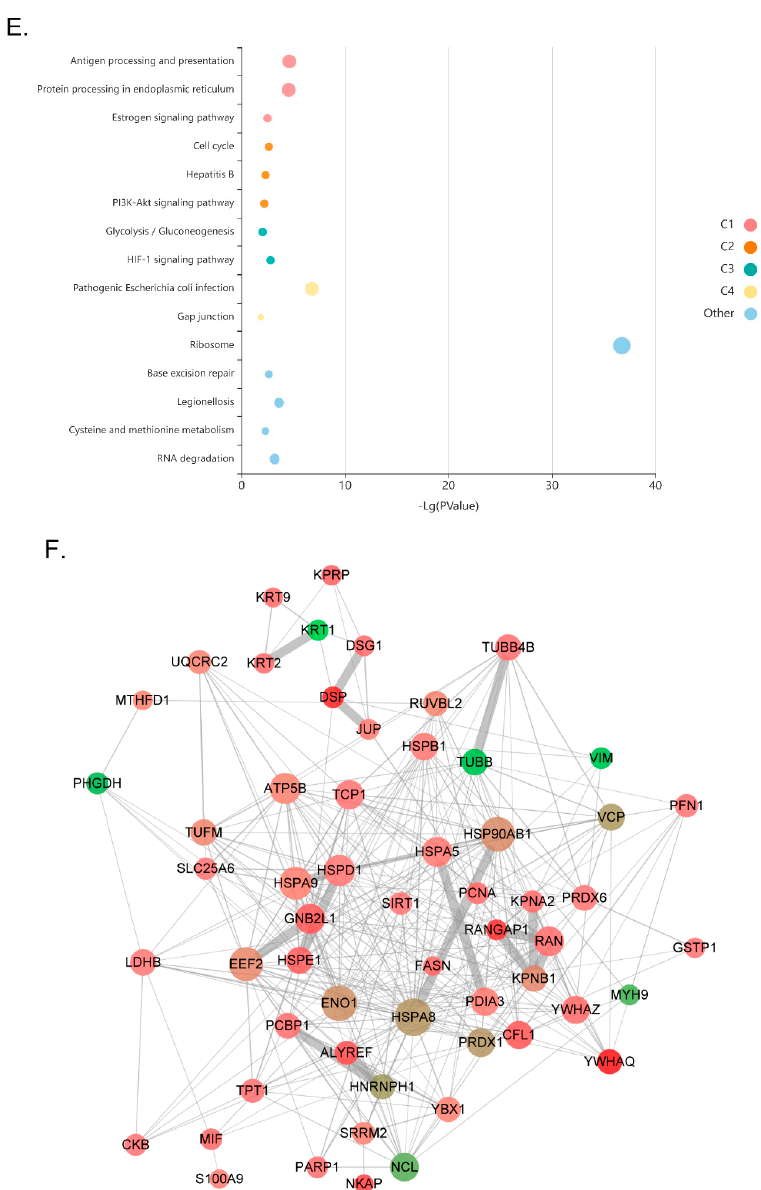
Figure 2. Proteomics analysis of activated SIRT1 interactome. ( A ) Workflow of SIRT1 interactions involving samples preparation and mass spectrometry analysis. ( B ) PCA analysis. SVD with im- putation was used to calculate principal components. X and Y axis showed principal component 1 and principal component 2 that explain 24.3% and 19.5% of the total variance, respectively. N = 9 data points. NC: negative control. CTR: control. Res: resveratrol. ( C ) Heatmap. ( D ) Enrichment of the expressed genes at the secondary GO Term in a significantly up-regulated or significantly down-regulated expression. The abscissa was the number of genes. The ordinate was the GO Term. ( E ) Enriched terms visualized in bubble plot. Each bubble represents an enriched function, and the size of the bubble from small to large: [0.05, 1], [0.01, 0.05), [0.001, 0.01), [0.0001, 0.001), [1 × 10 − 10 , 0.0001), [0, 1 × 10 − 10 ). The color of the bar is the same as the color in the circular network, which represents different clusters. For each cluster, if there are more than 5 terms, the top 5 with the highest enrich ratio were displayed. ( F ) Dramatic changes of biotinylated proteins were visualized by string database. The biotinylated protein level reduced by resveratrol was filled in green; the increased level was filled in red. The size of the circle and depth of color indicate the fold changes, the larger circles and deeper colors mean a higher fold